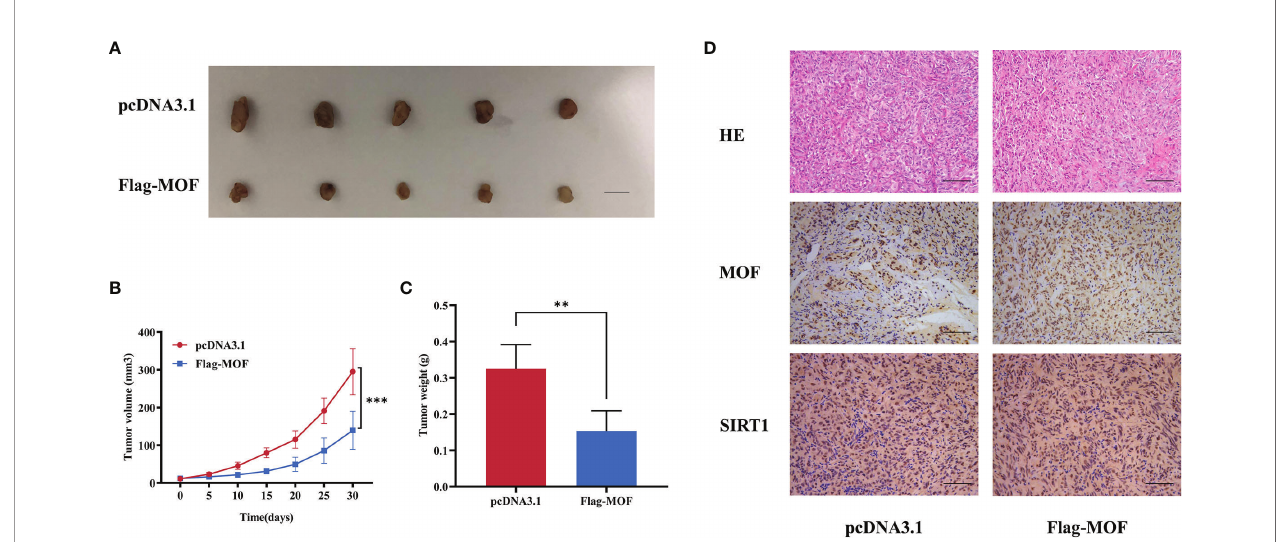
FIGURE 6 | The effect of MOF on renal cell carcinoma cell growth in vivo . (A) Tumor xenograft model in nude mice. MOF-overexpressed 769-P cells and control cells were inoculated to the fl ank of nude mice. Scale bar, 1 cm. (B, C) The tumor volume (B) and tumor weight (C) were analyzed. (D) H&E staining showed the tissue morphology. Representative images of MOF and SIRT1 staining in the indicated tumor tissues. Scale bar, 100 m m. (**, p < 0.01, ***, p <